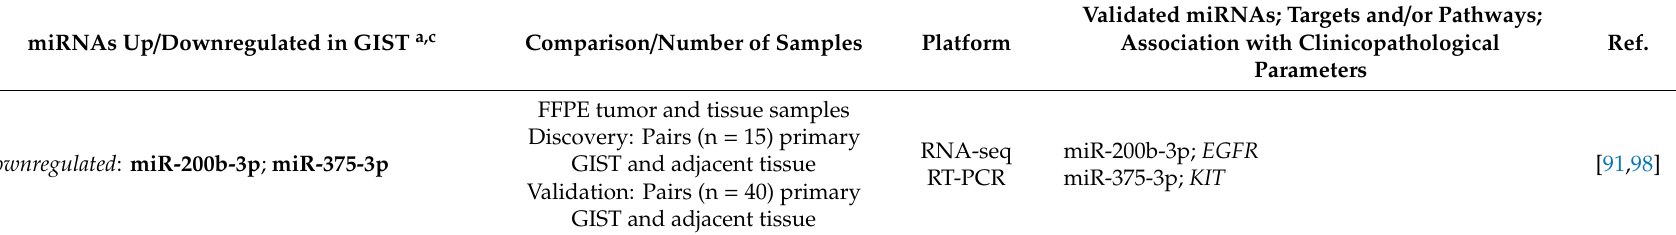
Validated miRNAs; Targets and / or Pathways; Association with Clinicopathological Parameters